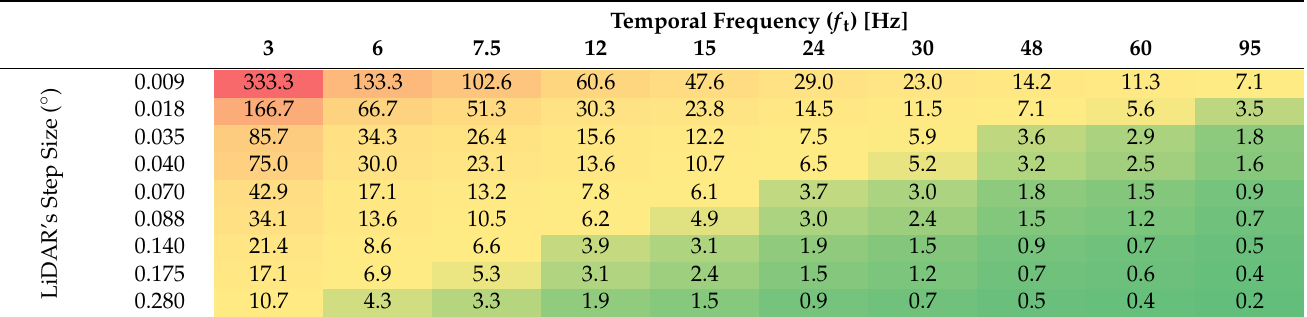
Table 10. Minutes per Scan. Based on the Angular Frequency for a 360 ◦